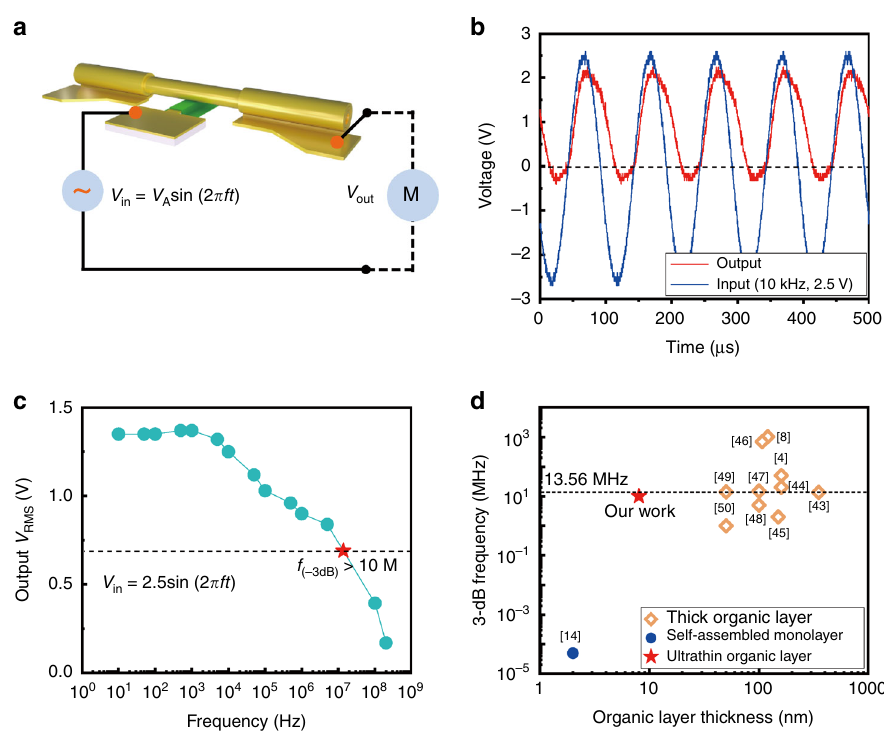
Fig. 5 Frequency performance of recti fi er based on Au ( fi nger)/F 16 CoPc (1 nm)/CuPc (7 nm)/Au (tube). a Measurement setup for frequency performance. The circuit is open, implying that the resistance of the load is in fi nite. b Recti fi cation behavior of Au ( fi nger)/F 16 CoPc (1 nm)/CuPc (7 nm)/ Au (tube) with W design = 10 μ m at 10 kHz. c Output DC voltage as a function of the input signal frequency. d Comparison of frequency performance between our organic recti fi er with previously reported